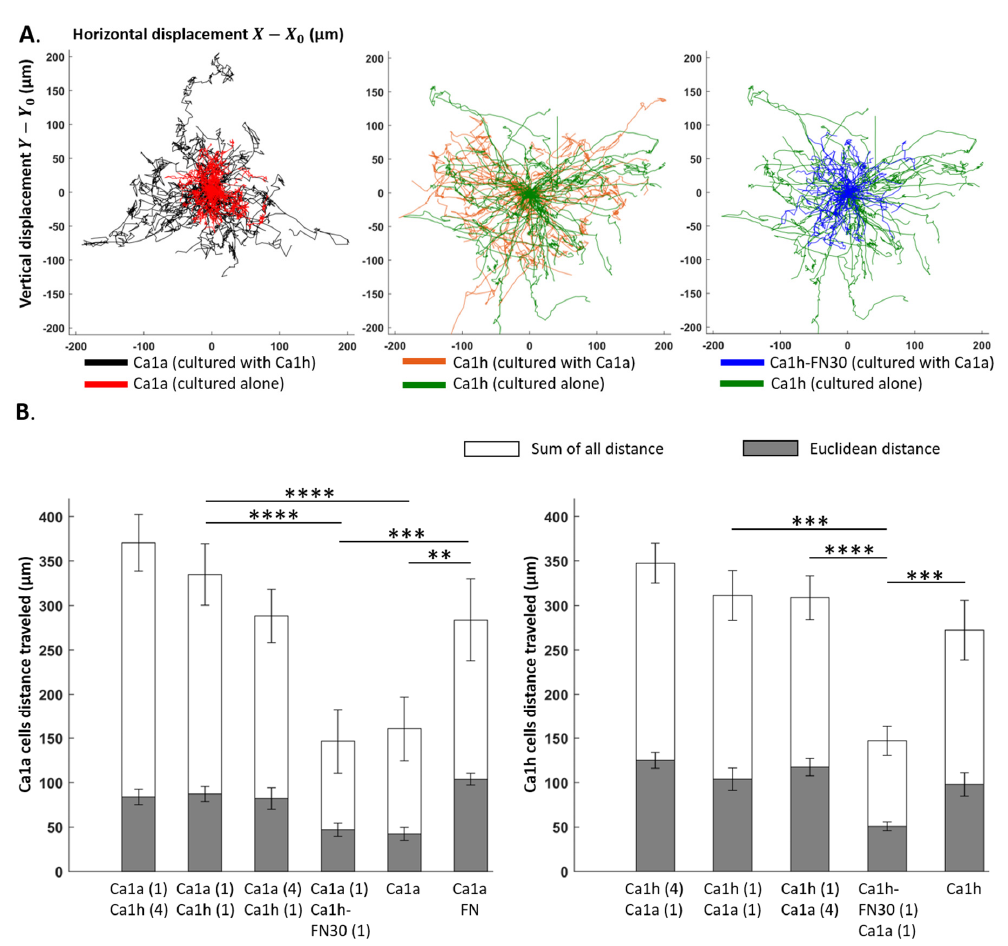
Figure 3. Trajectory of Ca1a and Ca1h cells in mono-culture and co-culture within the microfluidic chamber. ( A ) Tumor cell trajectory maps showing the full migration records of the representative 50 cells with the longest travel distance. ( B ) Mean Euclidean and the sum of all distances traveled quantified for Ca1a and Ca1h cells across the culture conditions. p -values are denoted with asterisks (*) as follows: **: significant at p < 0.01, ***: significant at p < 0.001, and ****: significant at p < 0.0001. Cancers 2020 , 12 , x